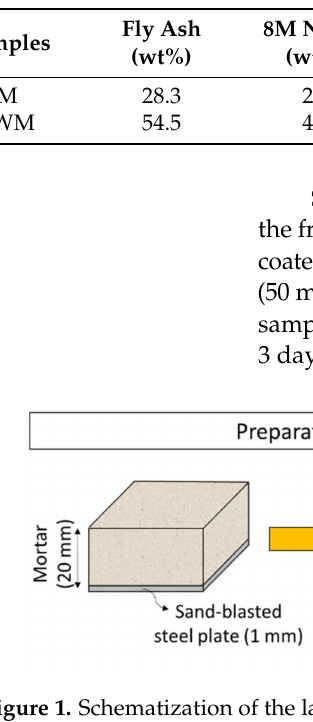
Table 1. Mix design of the prepared mortar samples.